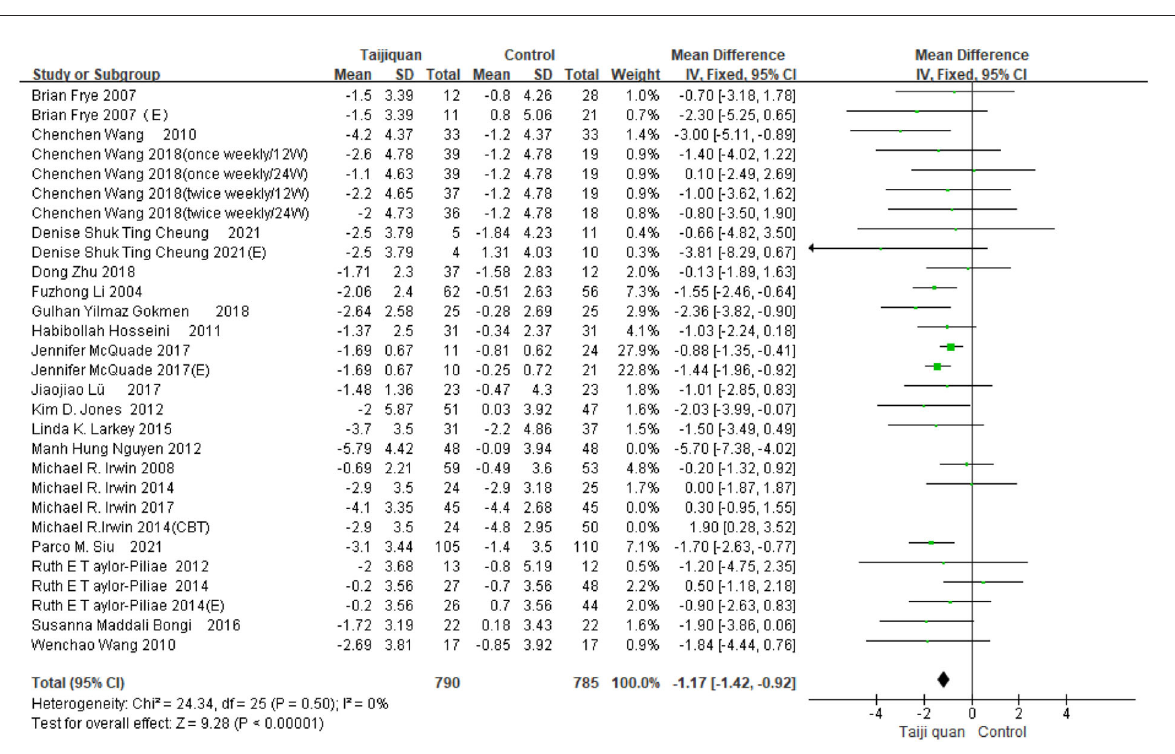
FIGURE7 After deleting three studies, the PSQI forest plot of the remaining